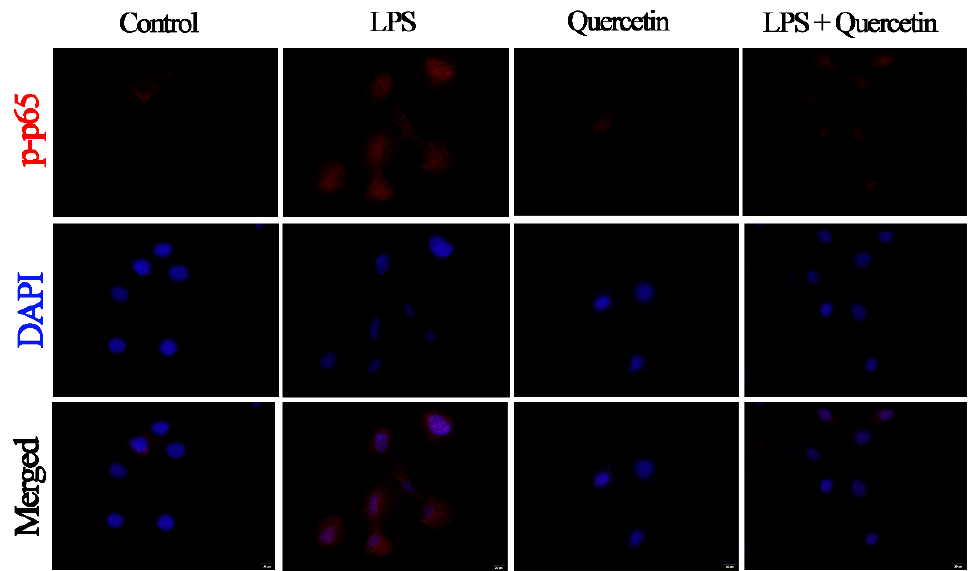
Figure 8. Impact of quercetin on the NF- κ B (p65) signalling mechanism in LPS-induced BIECs. BIECs were treated with 80 µ g/mL quercetin in an environment of 5 µ g/mL LPS for 6 h. The immunofluorescence for phosphorylation-NF- κ B (p-p65) (red) was conducted and the nuclear dye 4 ′ , 6-diamidino-2-phenylindole (DAPI; blue) was included. Scale bar = 20 μ m.